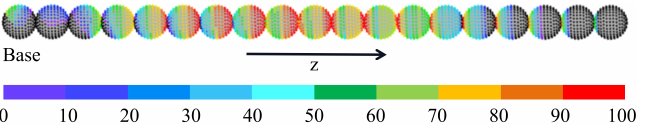
Figure 13. The distribution of the OAA index of the reachability spheres in Figure